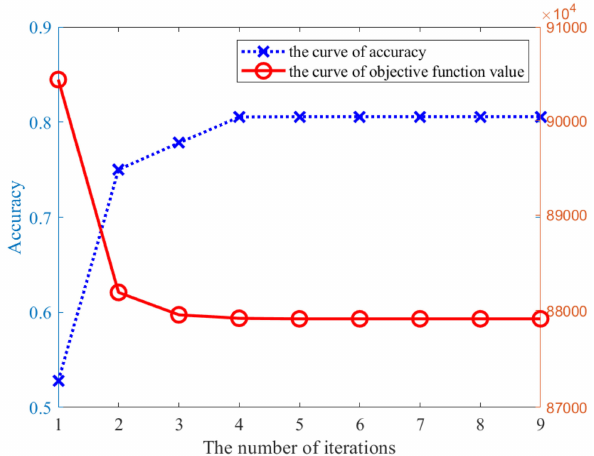
Figure 7. The objective function value and classification accuracy of CCT-HTD under different numbers of iterations.